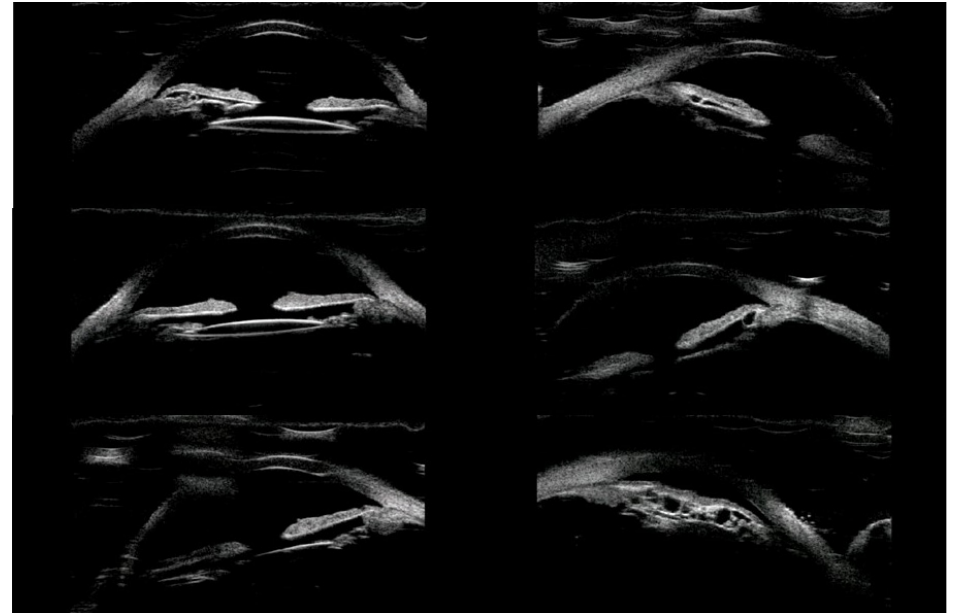
Figure 1. Small cyst of peripheral iris.